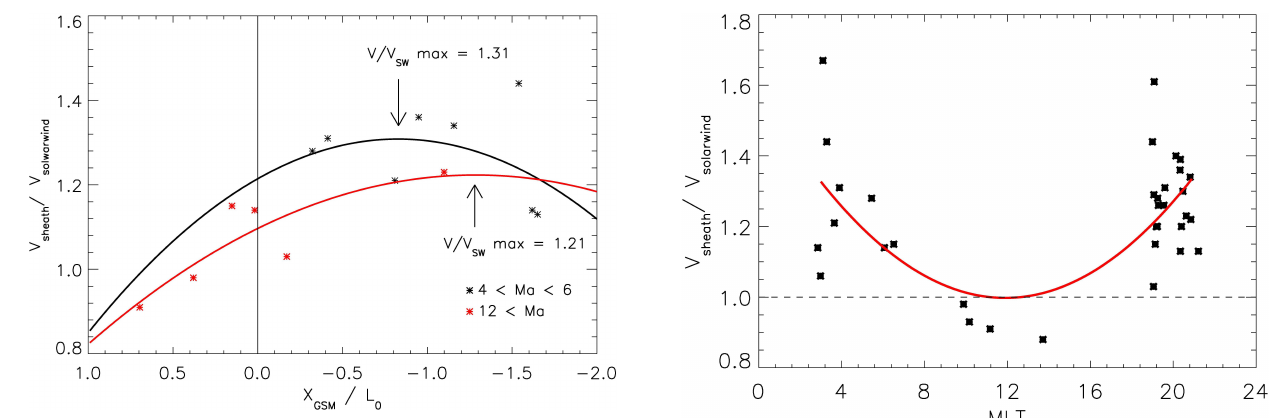
Fig. 7. This graph represents the ratio of the maximum magne- tosheath speed compared to the solar wind speed for all M A as a function of MLT. Note that the accelerations are smaller on the day side, and larger downtail of the terminators, as is suggested in the theory. Given the small number of points, this represents a semi- qualitative representation of observations for all M A and